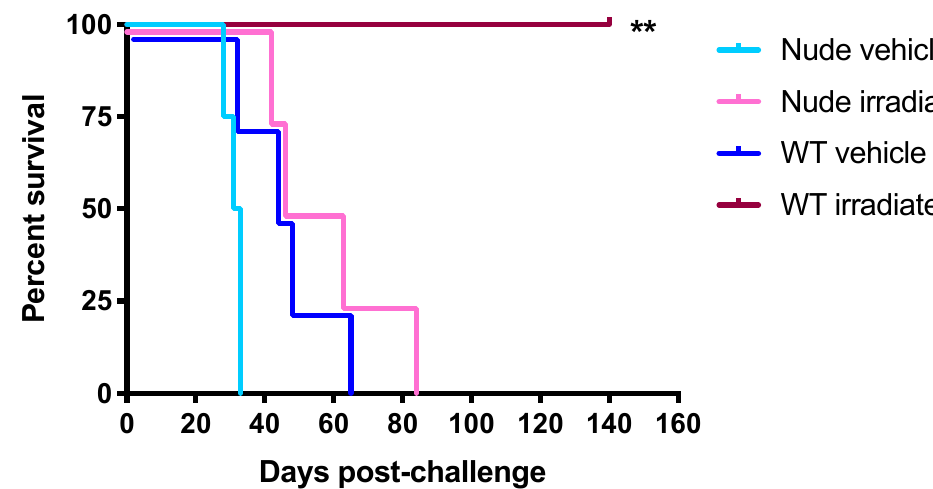
Figure 3. The survival benefit provided by the co-delivery of CPMV and irradiated cells is T cell-dependent. Irradiated ID8/VEGFA/defb29 cells were co-delivered IP with 100 µg CPMV to C57BL/6J (WT) or NU/J (nude) mice. Following two vaccinations seven days apart, mice were challenged with 5 × 10 6 live tumor cells. n = 4 in all groups. Compared to WT vehicle: WT irradiated + CPMV p = 0.007, nude irradiated + CPMV p = 0.29, and nude vehicle p = 0.10. Compared to nude vehicle, nude irradiated + CPMV p = 0.009. p values compare survival curves with a log-rank (Mantel–Cox) test. All p values are compared to vehicle-treated controls unless otherwise noted. ** 0.001 < p < 0.01; ns p > 0.05.